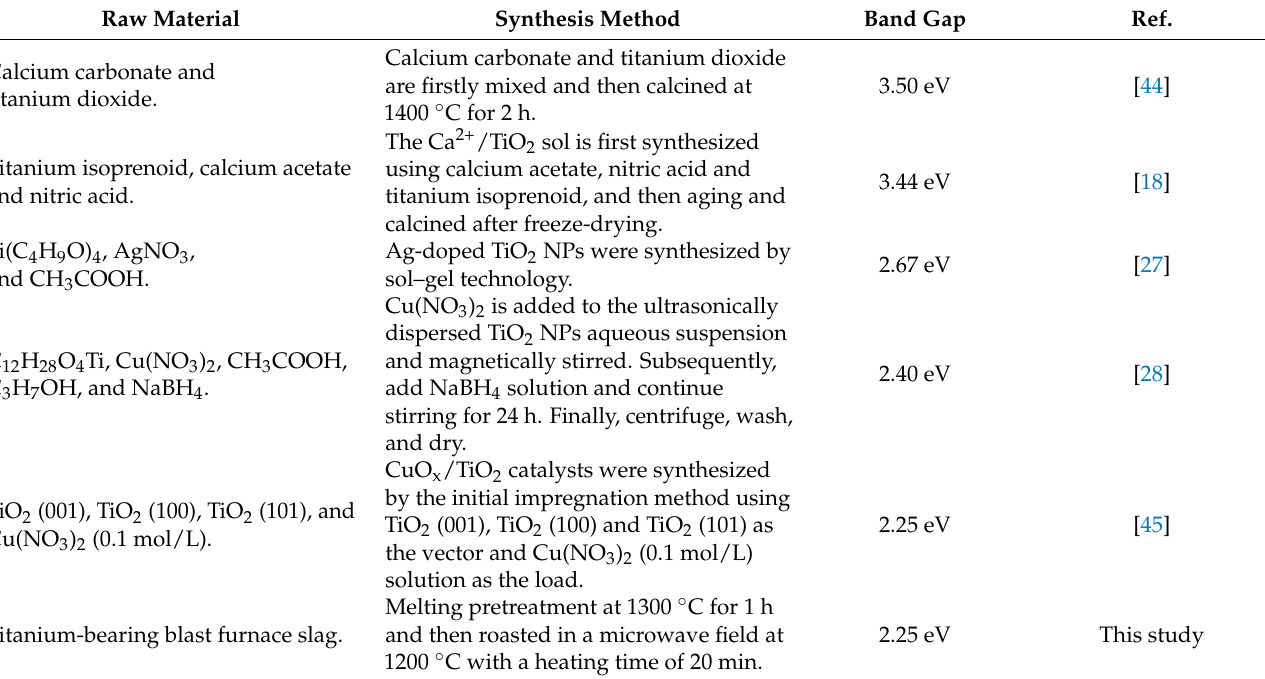
Table 4. Comparison of the band gap values of photocatalysts in different synthesis processes.